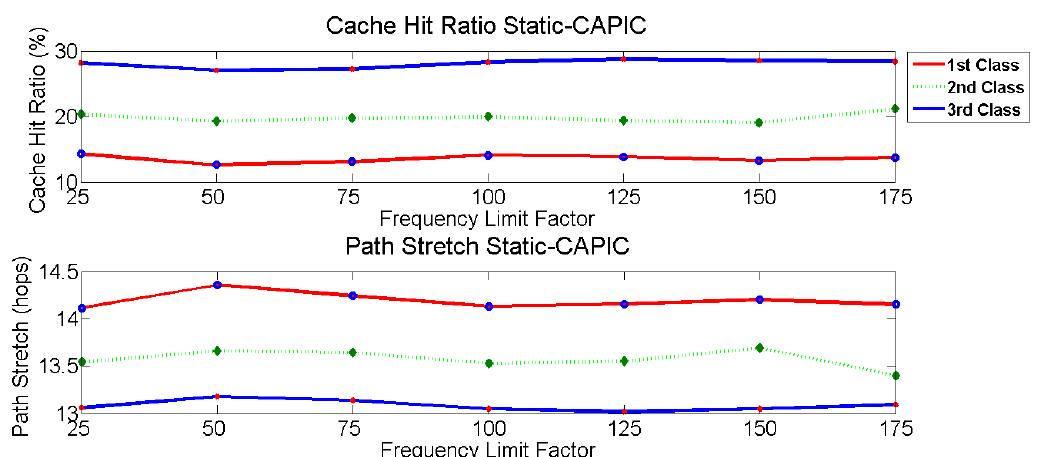
Figure 13. Performance of